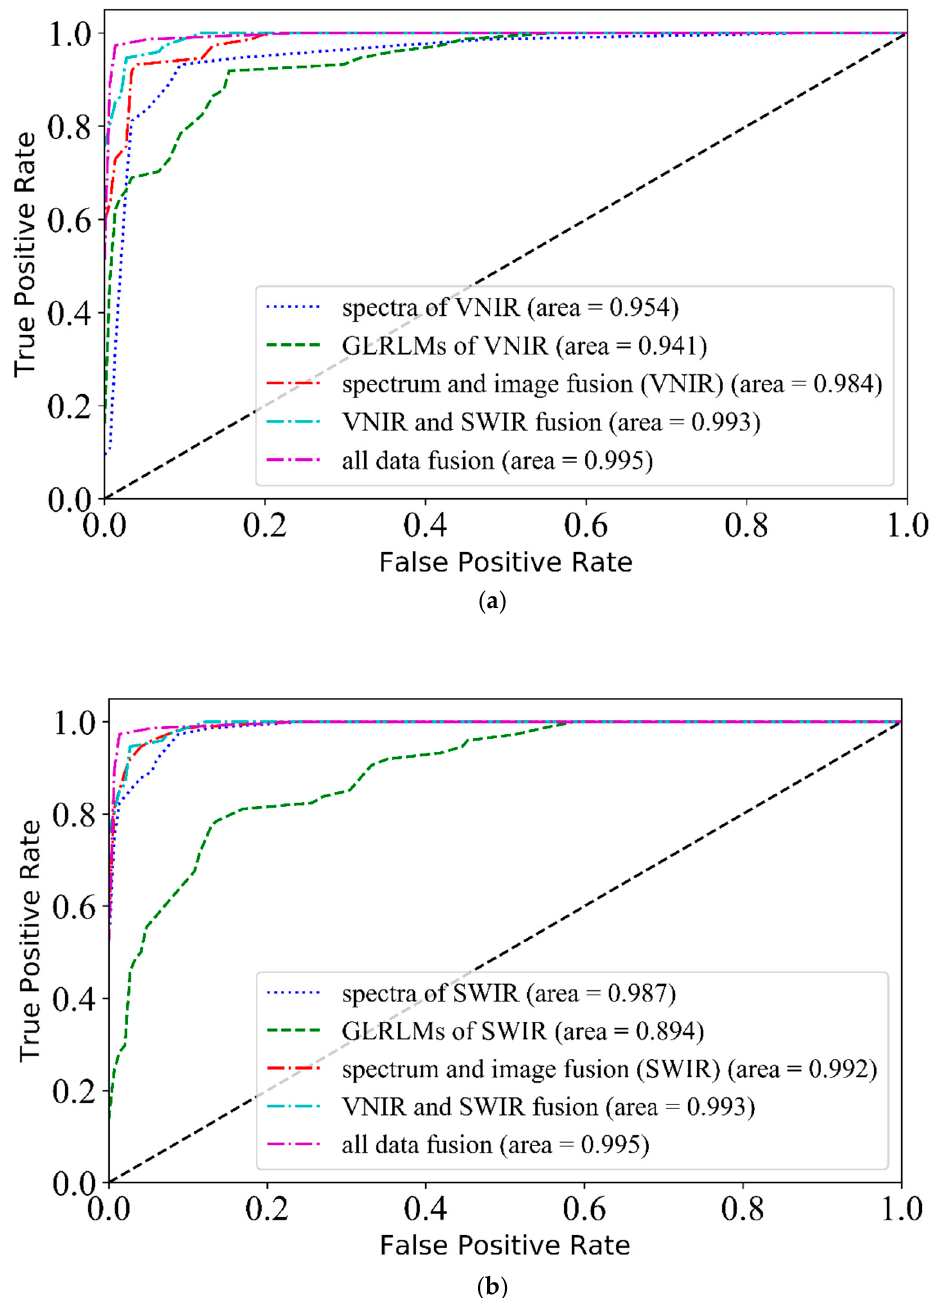
Figure 6. The receiver operating characteristics (ROC) curves of three fusion methods, full band spectra, and images in ( a ) the VNIR range and ( b ) the SWIR range based on the prediction set.